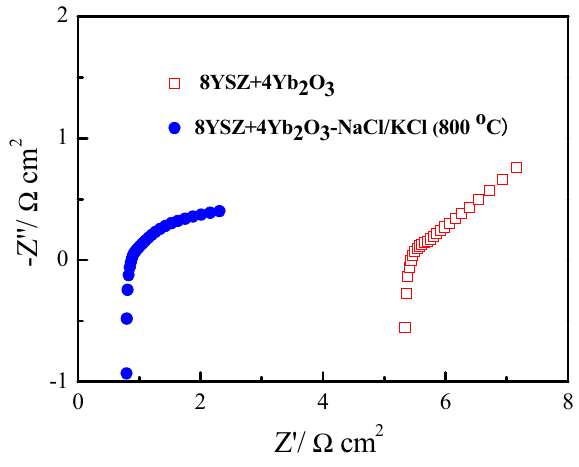
Figure 6. Typical impedance spectra of the 8YSZ+4Yb 2 O 3 and 8YSZ+4Yb 2 O 3 -NaCl/KCl (800 °C) samples measured at 700 °C under open-circuit conditions.